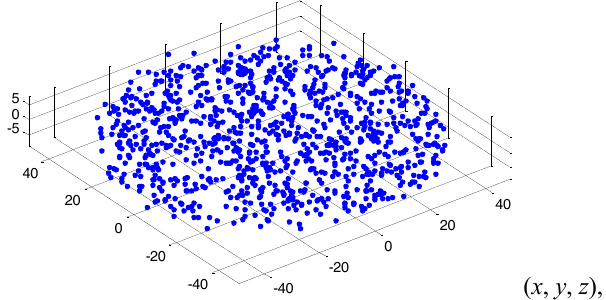
Fig. 4. Facet field of modeling reflectors of a homogeneous rough underlying